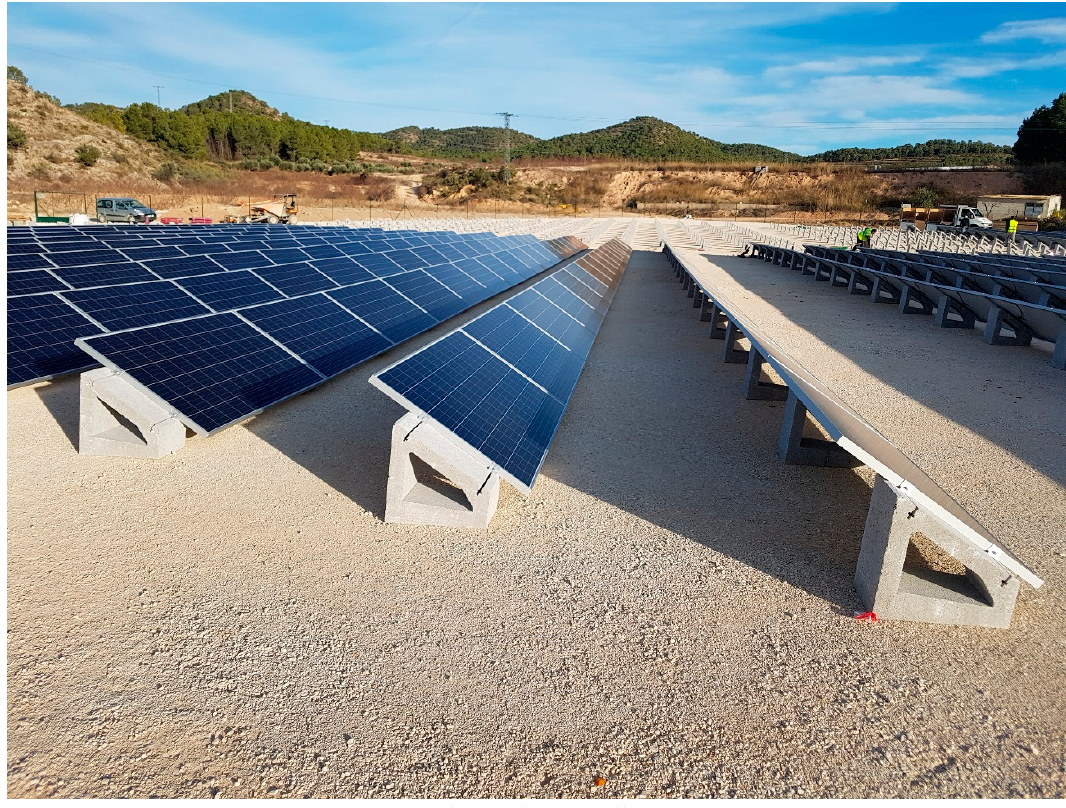
Figure 13. Photovoltaic installation.